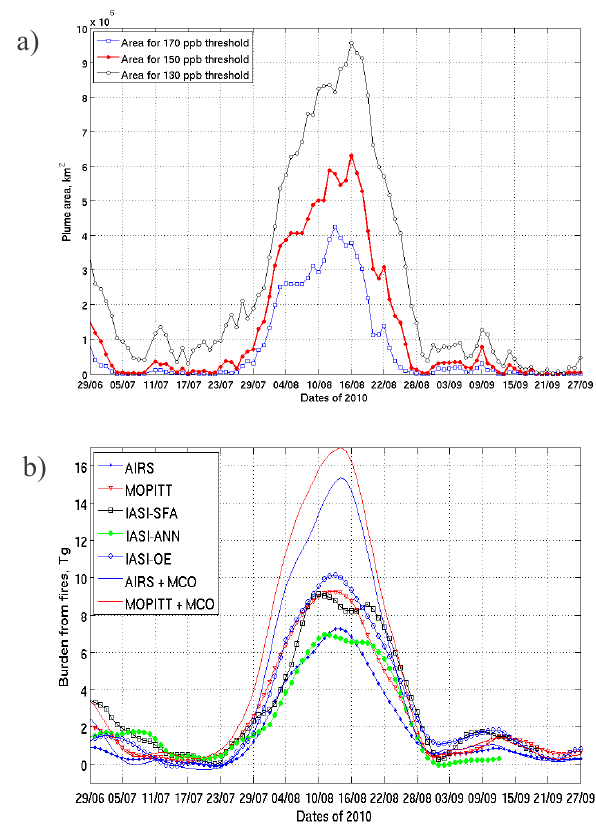
Fig. 12. (a) Plume area for 3 selected boundaries (170, 150, and 130ppb) over Russia in 2010. (b) CO extra burden due to fires (total burden subtracted by background). First five lines are for standard retrieval. Last two lines demonstrate the effect of correction for MCO in the case of 150ppb as a boundary of the